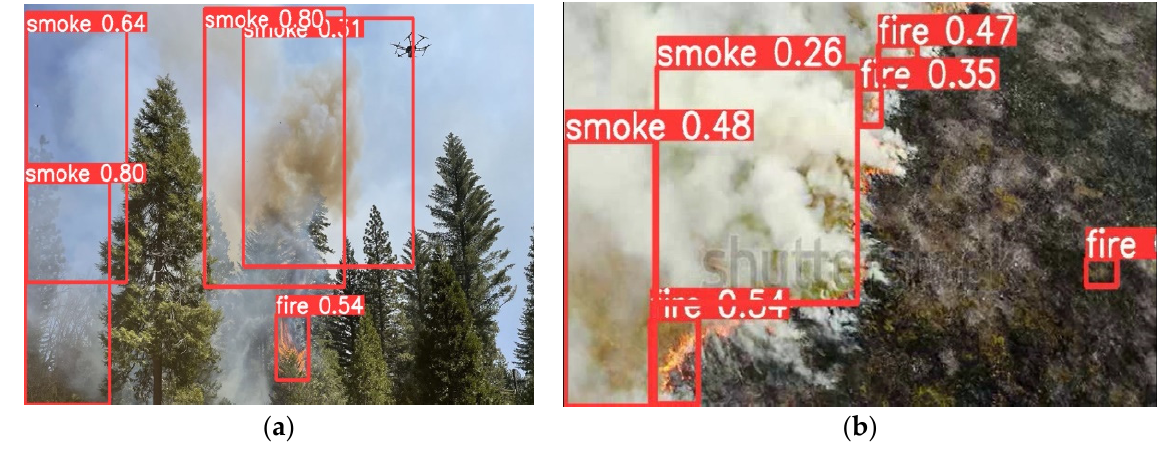
Figure 8. Two-stage results: smoke detection combined with fire detection (( a ) model 1 and ( b ) model 2) .